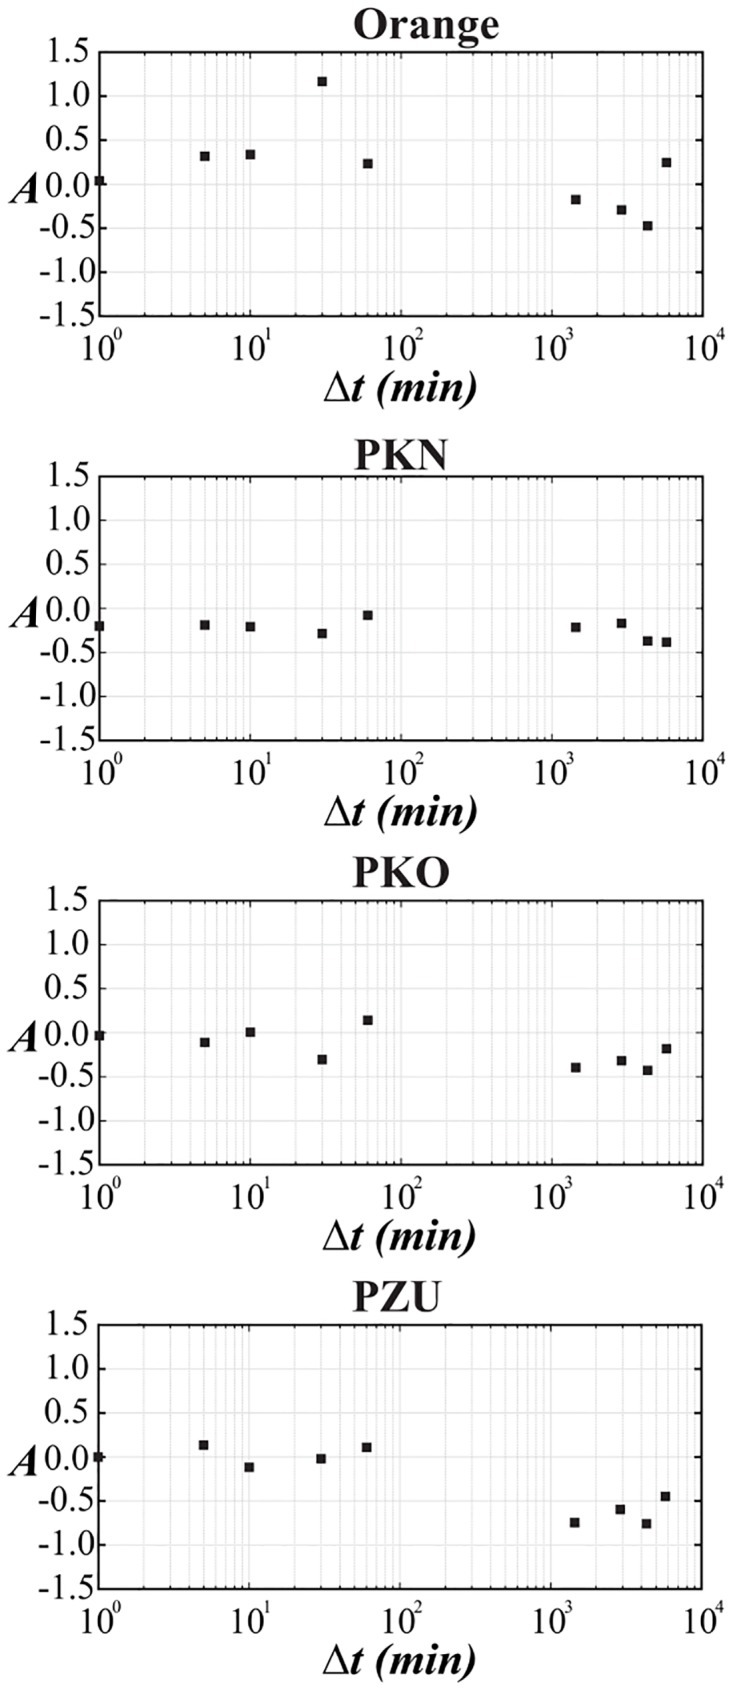
Dependence between skewness A versus the time-lag Δt in log-linear scale for chosen companies from WIG 30 stock index.The results seem to be much less informative than those from Fig 6.